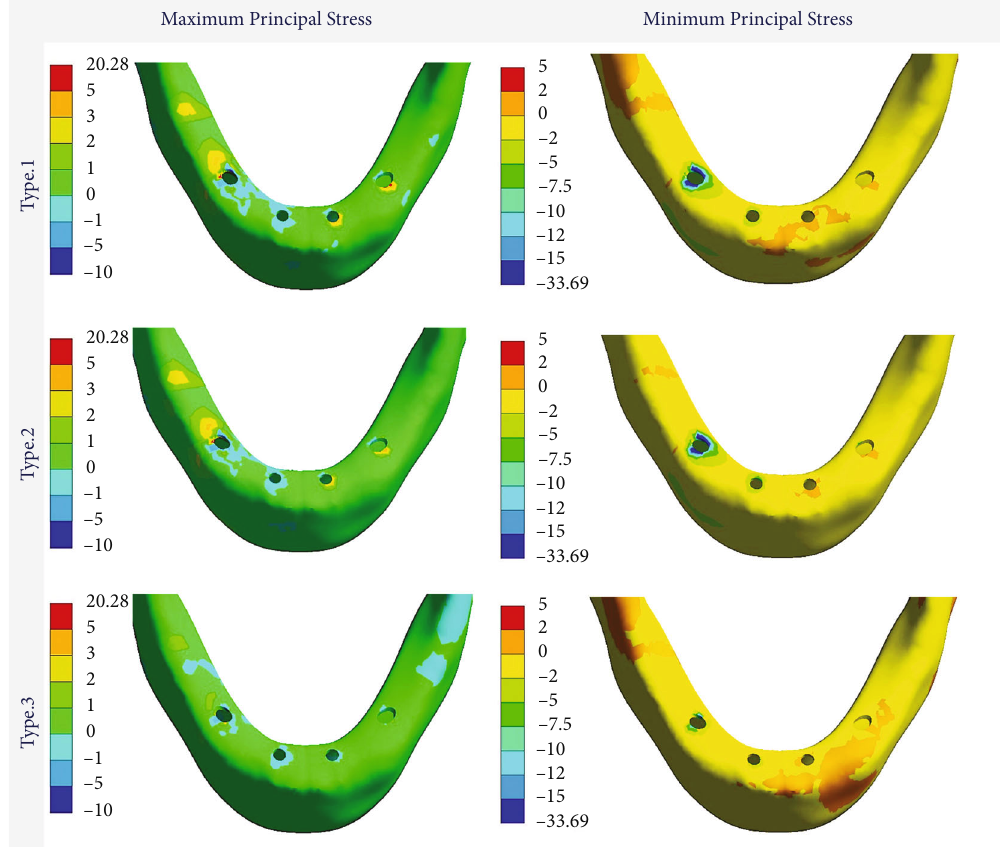
Figure 9: Maximum and minimum principal stresses (MPa) on cancellous